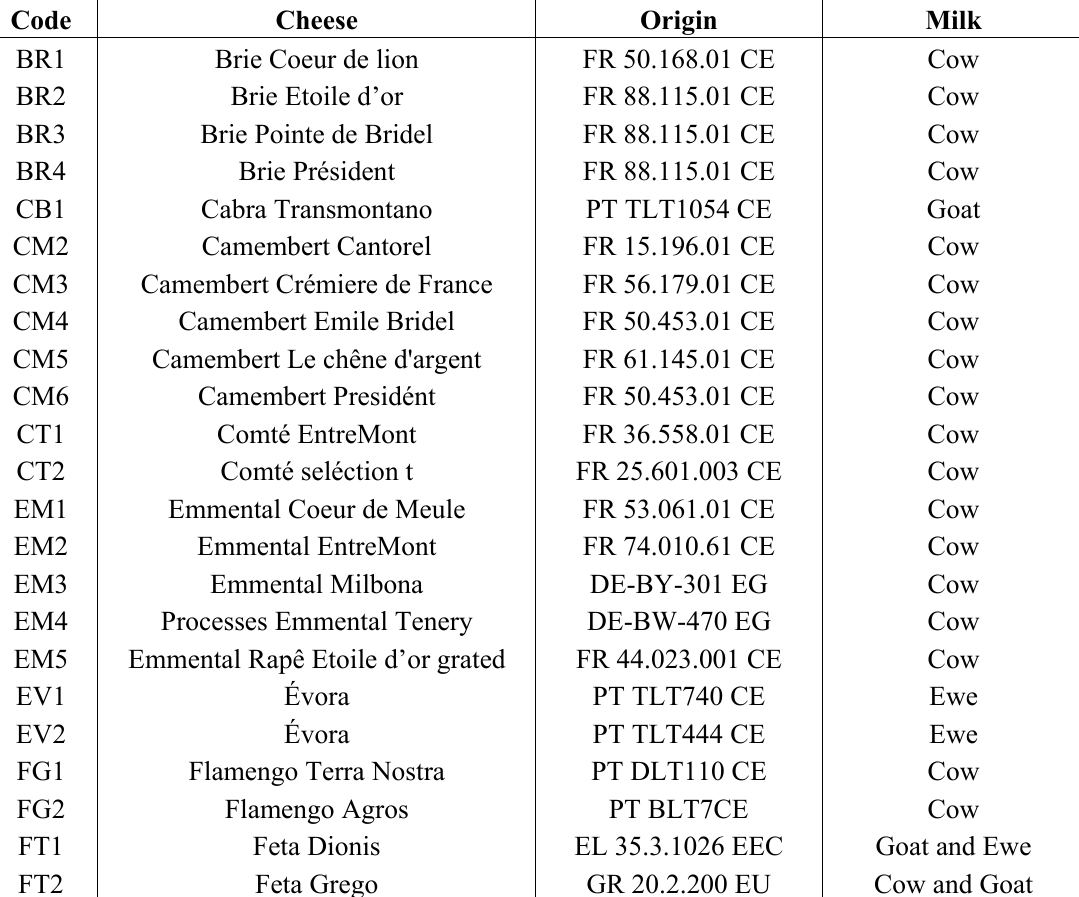
Table 1. Analysed